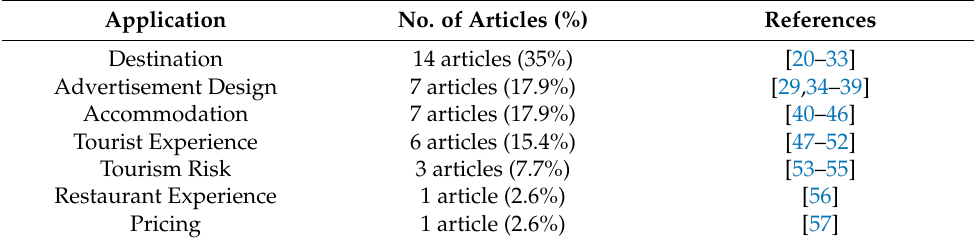
Table 1. Applications in